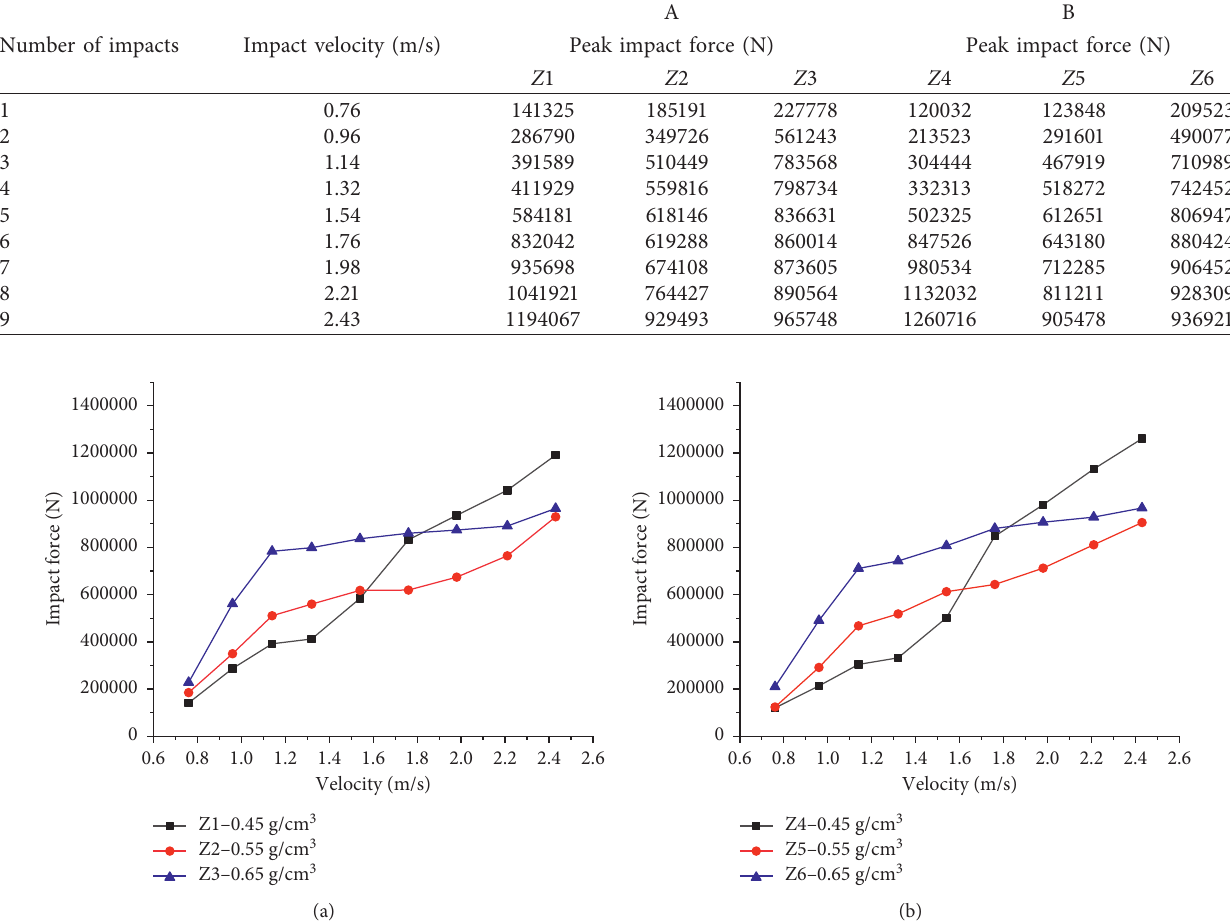
Table 5: Impact force tests and comparison results.